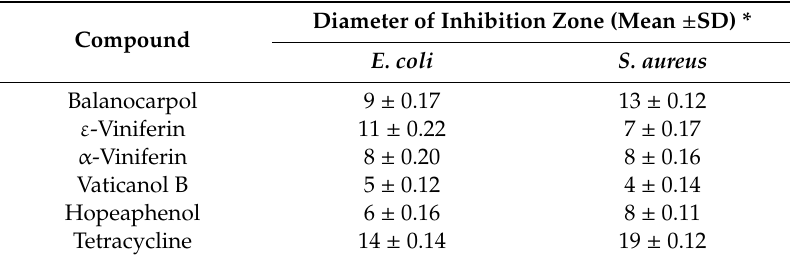
Table 14. Antibacterial activity of the isolated compounds from Sahidin et al. (2017) [108].